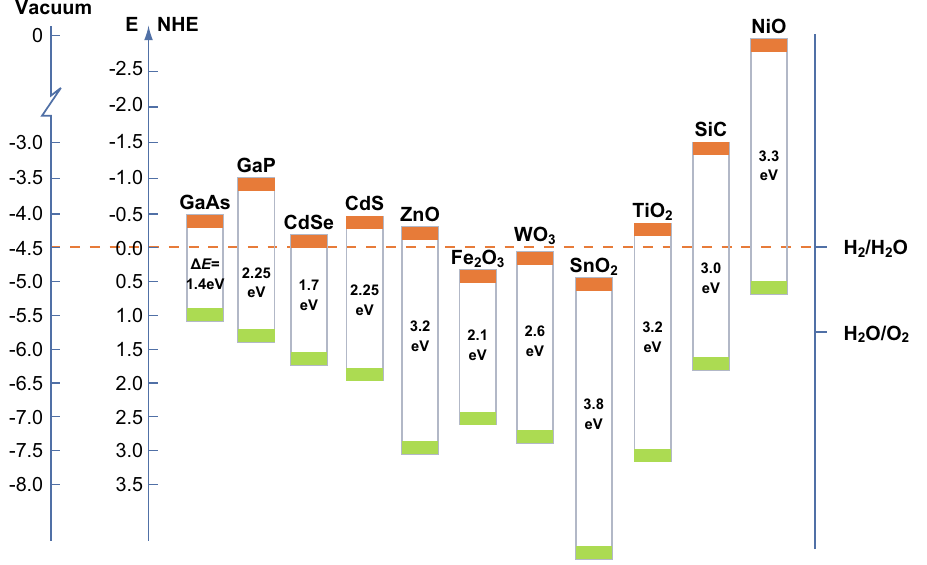
Fig. 1 Schematic overview of the band positions of representative semiconductors